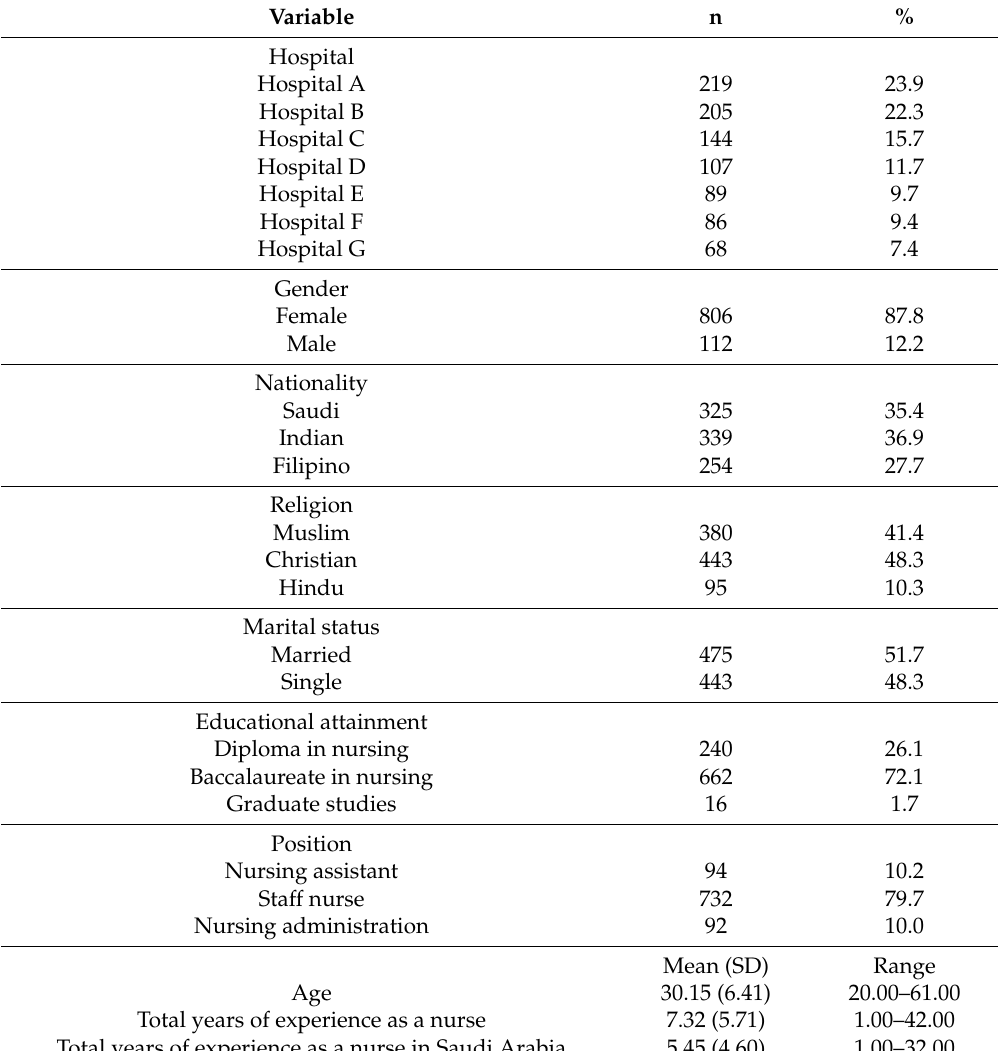
Table 1. The demographic and work-related variables of the respondents (n =